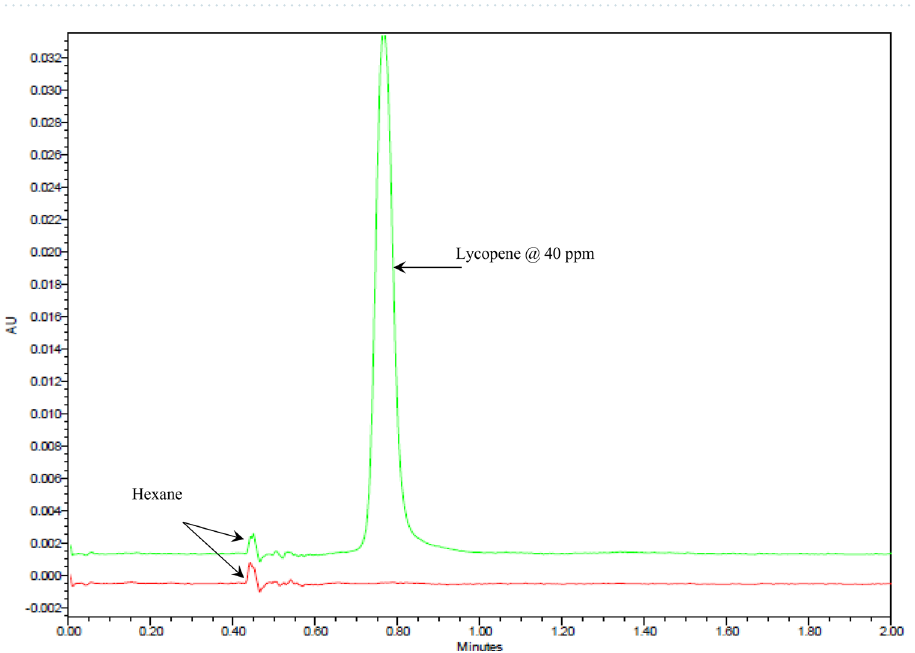
Figure 2. Chromatograms for blank (hexane) and hexane spiked with 40 ppm lycopene standard at using BEH 2 EP 2.1 × 150 mm, 5 µm column at optimized experimental